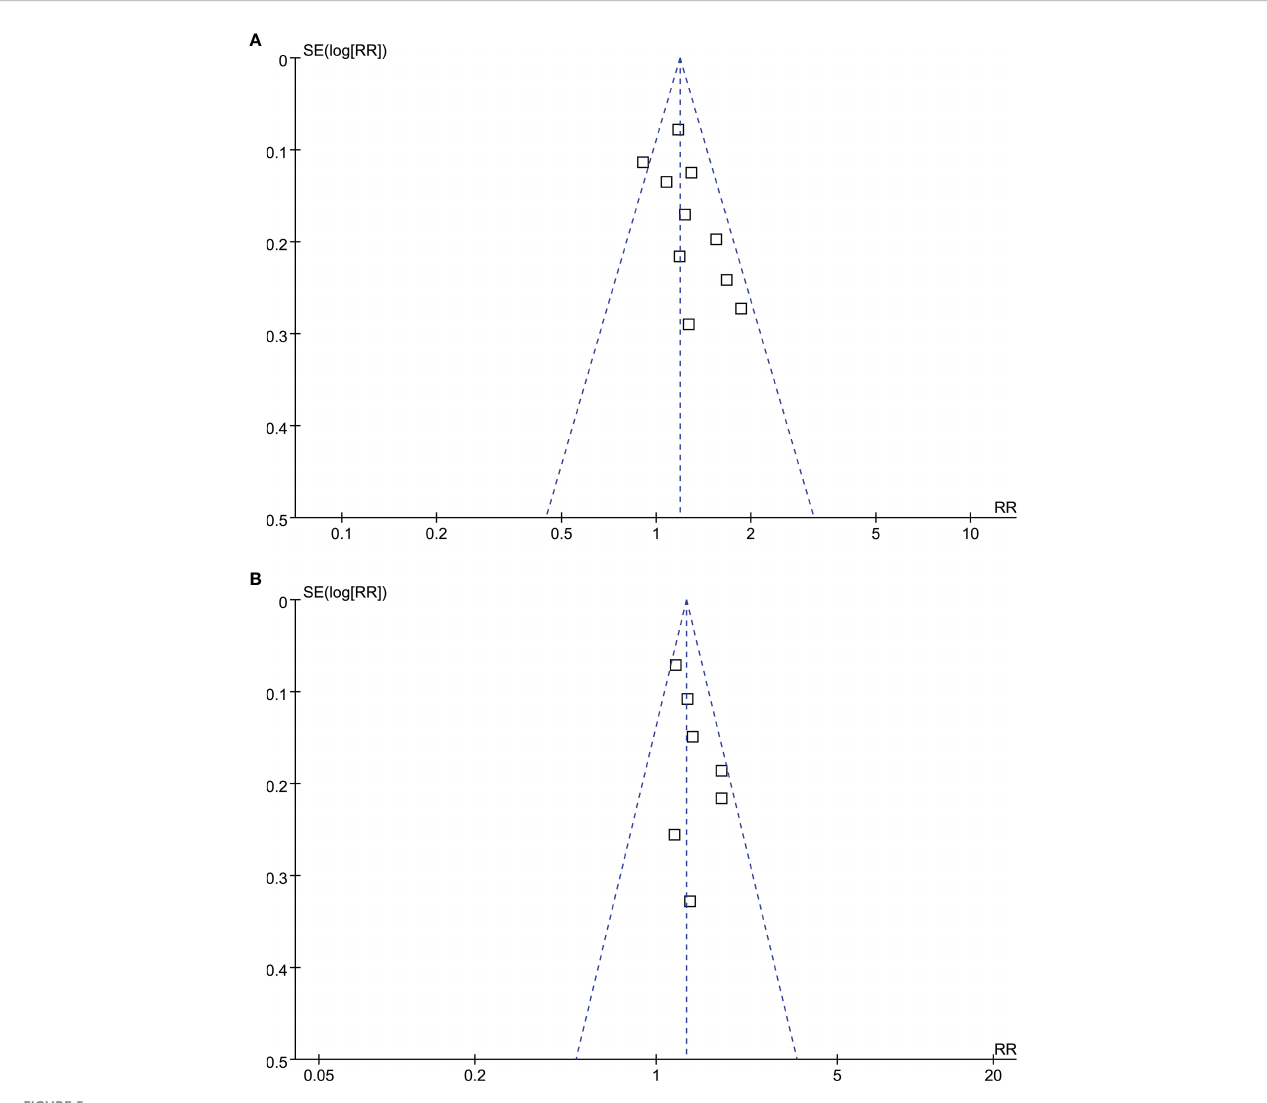
FIGURE 5 Funnel plots for the publication bias underlying the meta-analyses; (A) funnel plots for the meta-analysis of OS; and (B) funnel plots for the meta-analysis of